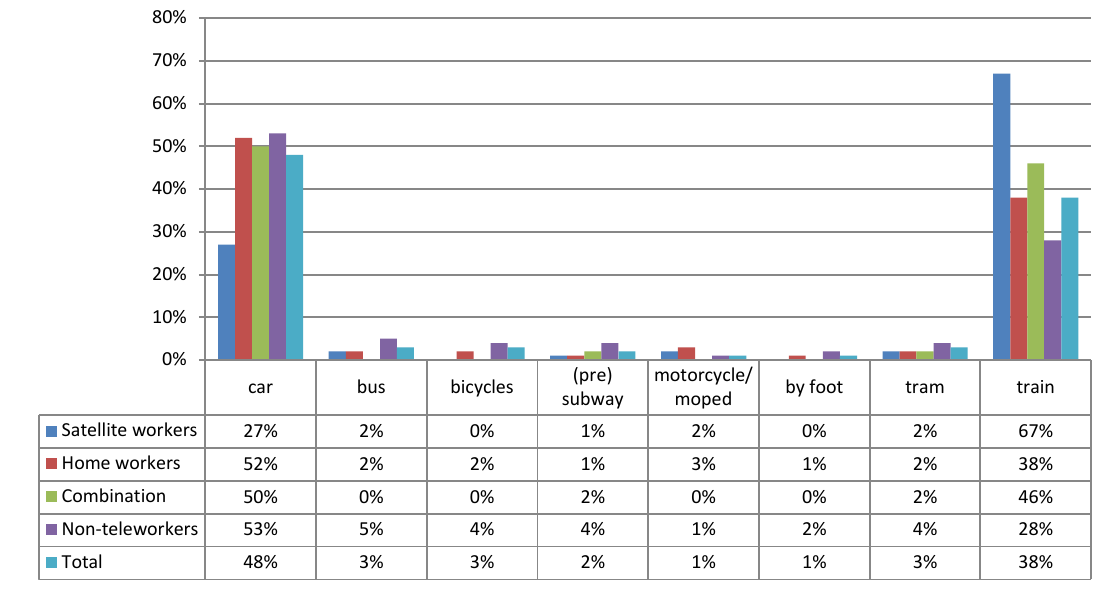
Figure 3. Transport mode to headquarter office (MOBI, 2012) Both commuting distances and commuting times to HQ are on average higher for teleworkers compared to non-teleworkers. Non-teleworkers travel on average 35 km and 54 minutes to HQ. Satellite office teleworkers have an average commuting distance and commuting time to HQ of 60 km and 91 min, which can be reduced by teleworking at the satellite office to 22 km and 30 minutes. The impact on mobility is of course even higher when teleworking at home. 52% of homeworkers use the car to commute to HQ over an average distance of approximately 45 km and with a related commuting time of 64 min. On teleworking days, these commuting trips can be completely avoided. Teleworking and flexible working hours thus show a clear potential to improve mobility by reducing commuting kilometres and avoiding peak hour